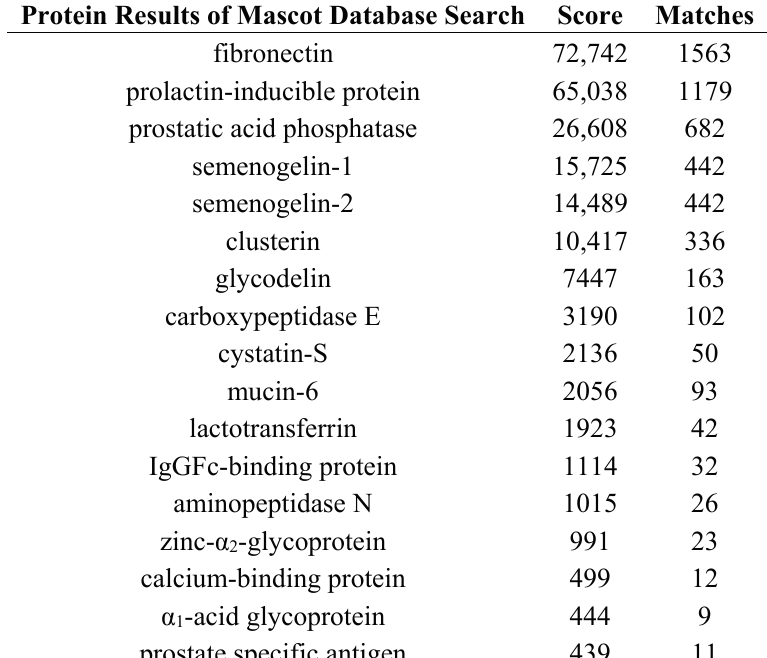
Figure 5. Isolation of GNL-reactive glycoproteins by means of affinity chromatography. ( A ) GNL reactivity of the pooled sample submitted to the column, BCIP/NBT stained; ( B ) GNL reactivity of column unbound glycoproteins, DuoLux stained; ( C ) GNL reactivity of α -methyl- D -mannopyranoside released glycoproteins, DuoLux stained; ( D ) Sypro Ruby stained proteins of α -methyl- D -mannopyranoside released glycoproteins. Table 2. Mass spectrometry identification of proteins isolated in